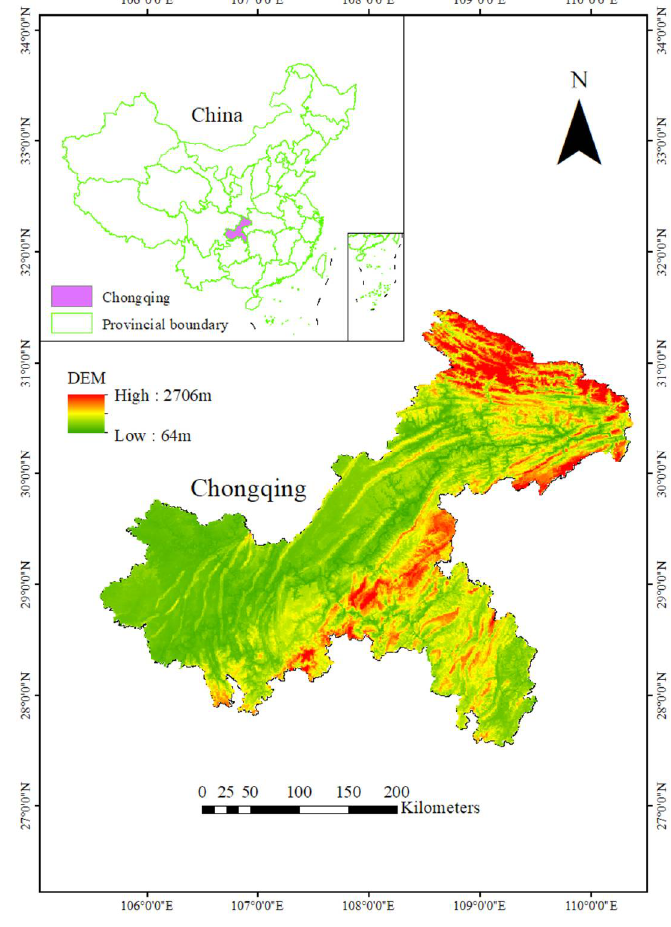
Figure 1. Location of Chongqing.